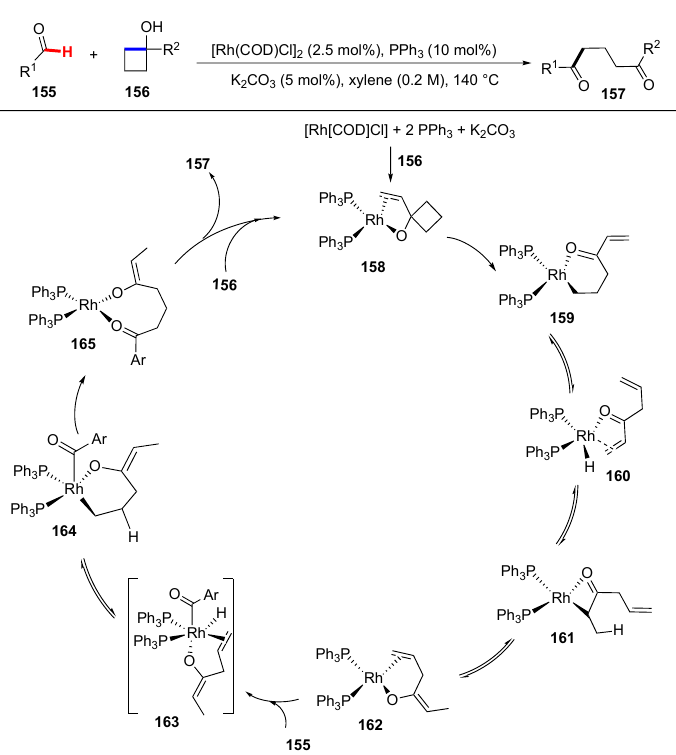
Scheme 19. Rh-catalyzed synthesis of 1,5-diketones.